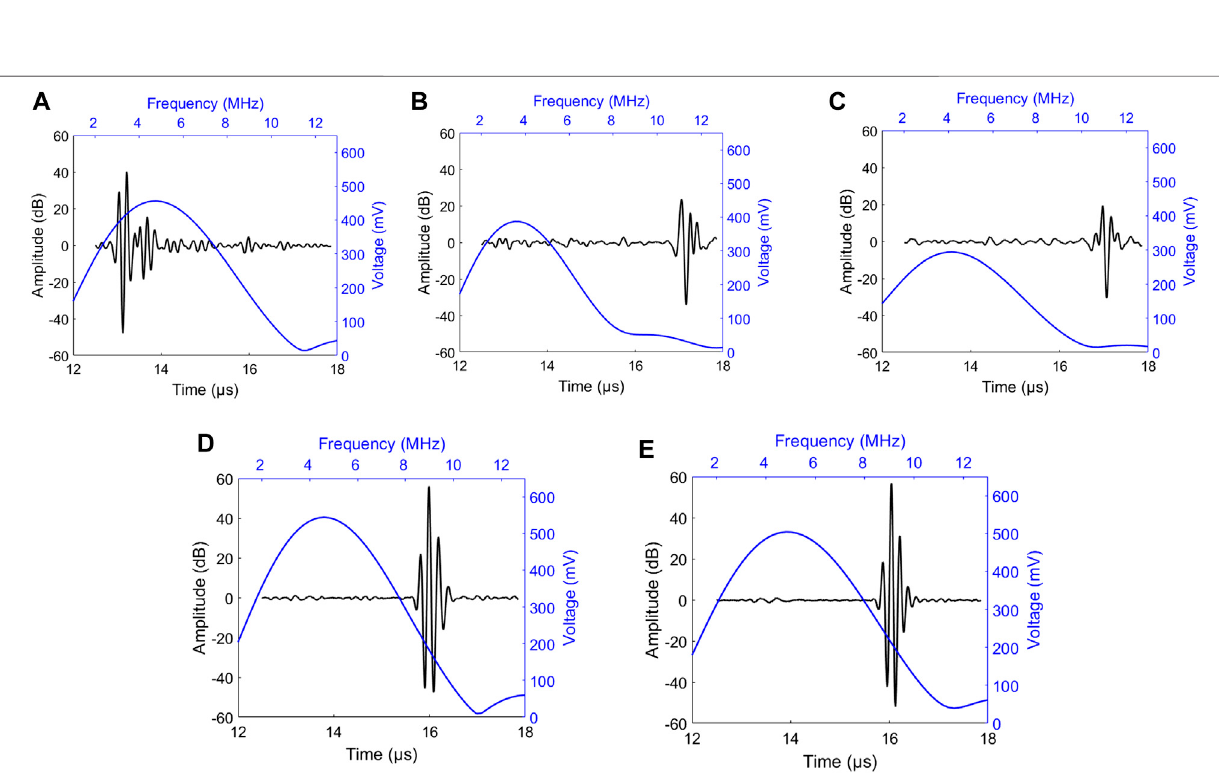
Frontiers in Materials |